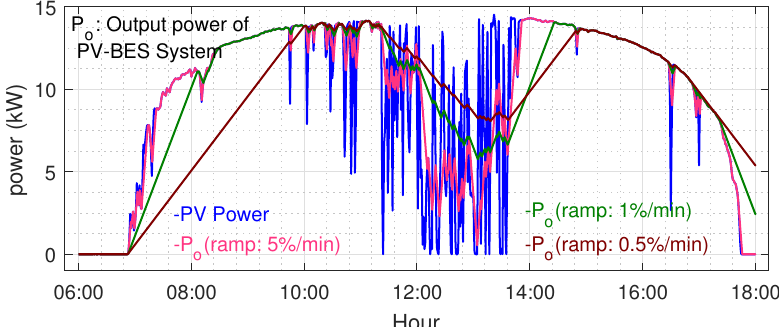
Figure 18. Output power of the proposed PV-BES system for different ramp settings in response to the real solar irradiance data.